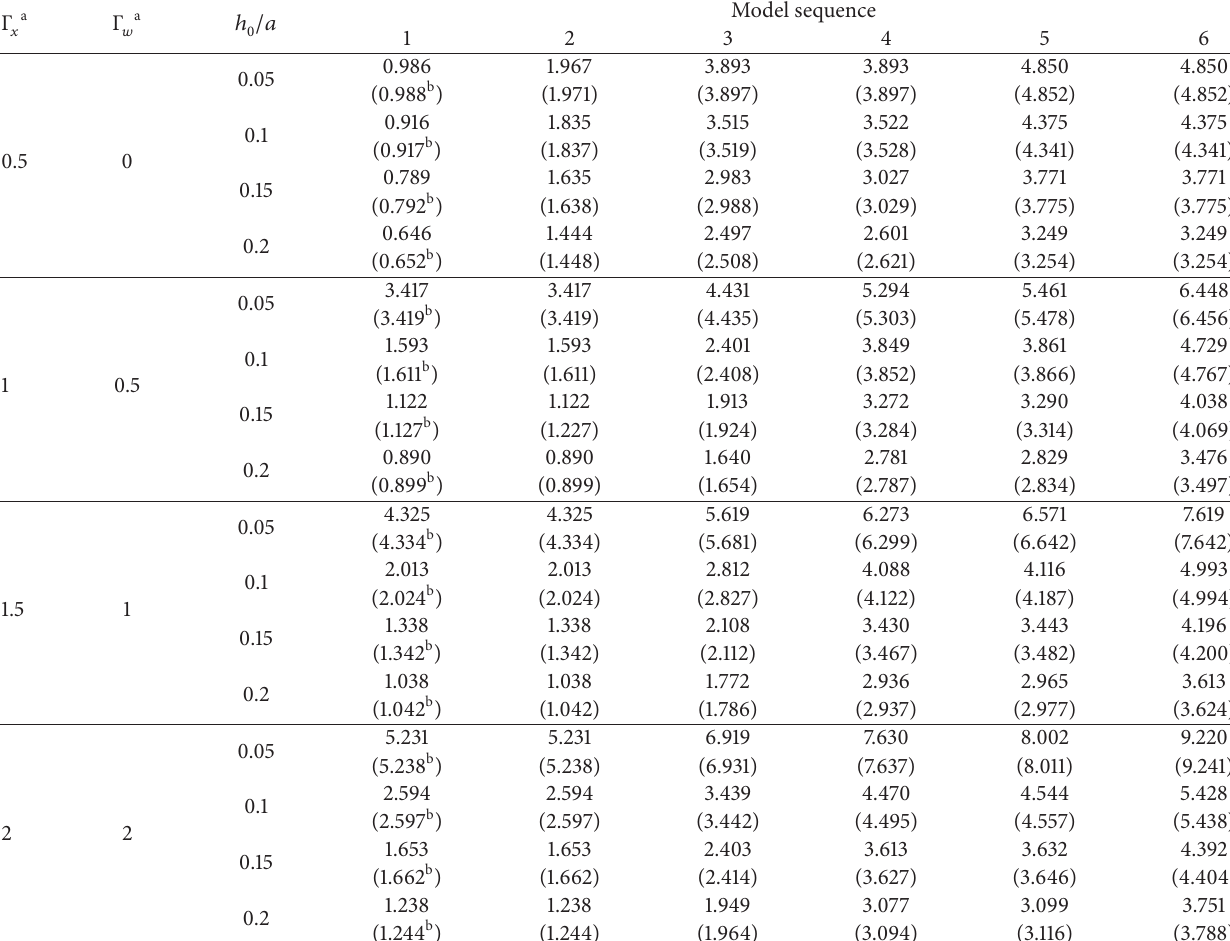
Table 4: Frequency parameters Ω = 𝜔𝑏 2 (𝜌ℎ/𝐷) 1/2 /𝜋 2 for moderately thick plates ( 𝑎/𝑏 = 1 ) with uniform thickness and all edge elastic